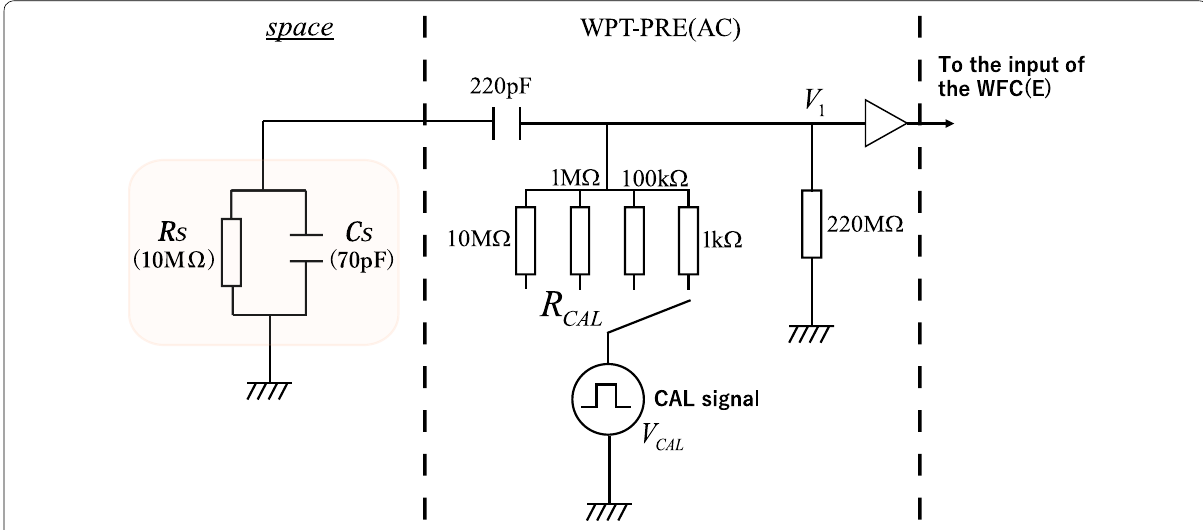
Fig. 14 A simplified schematic diagram of the calibration circuit onboard the EWO receiver